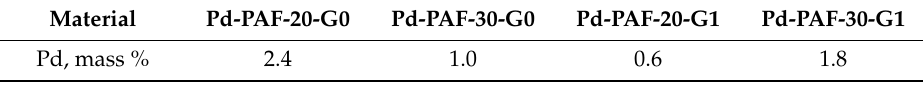
Table 3. Palladium content by atomic absorption spectroscopy in synthesized